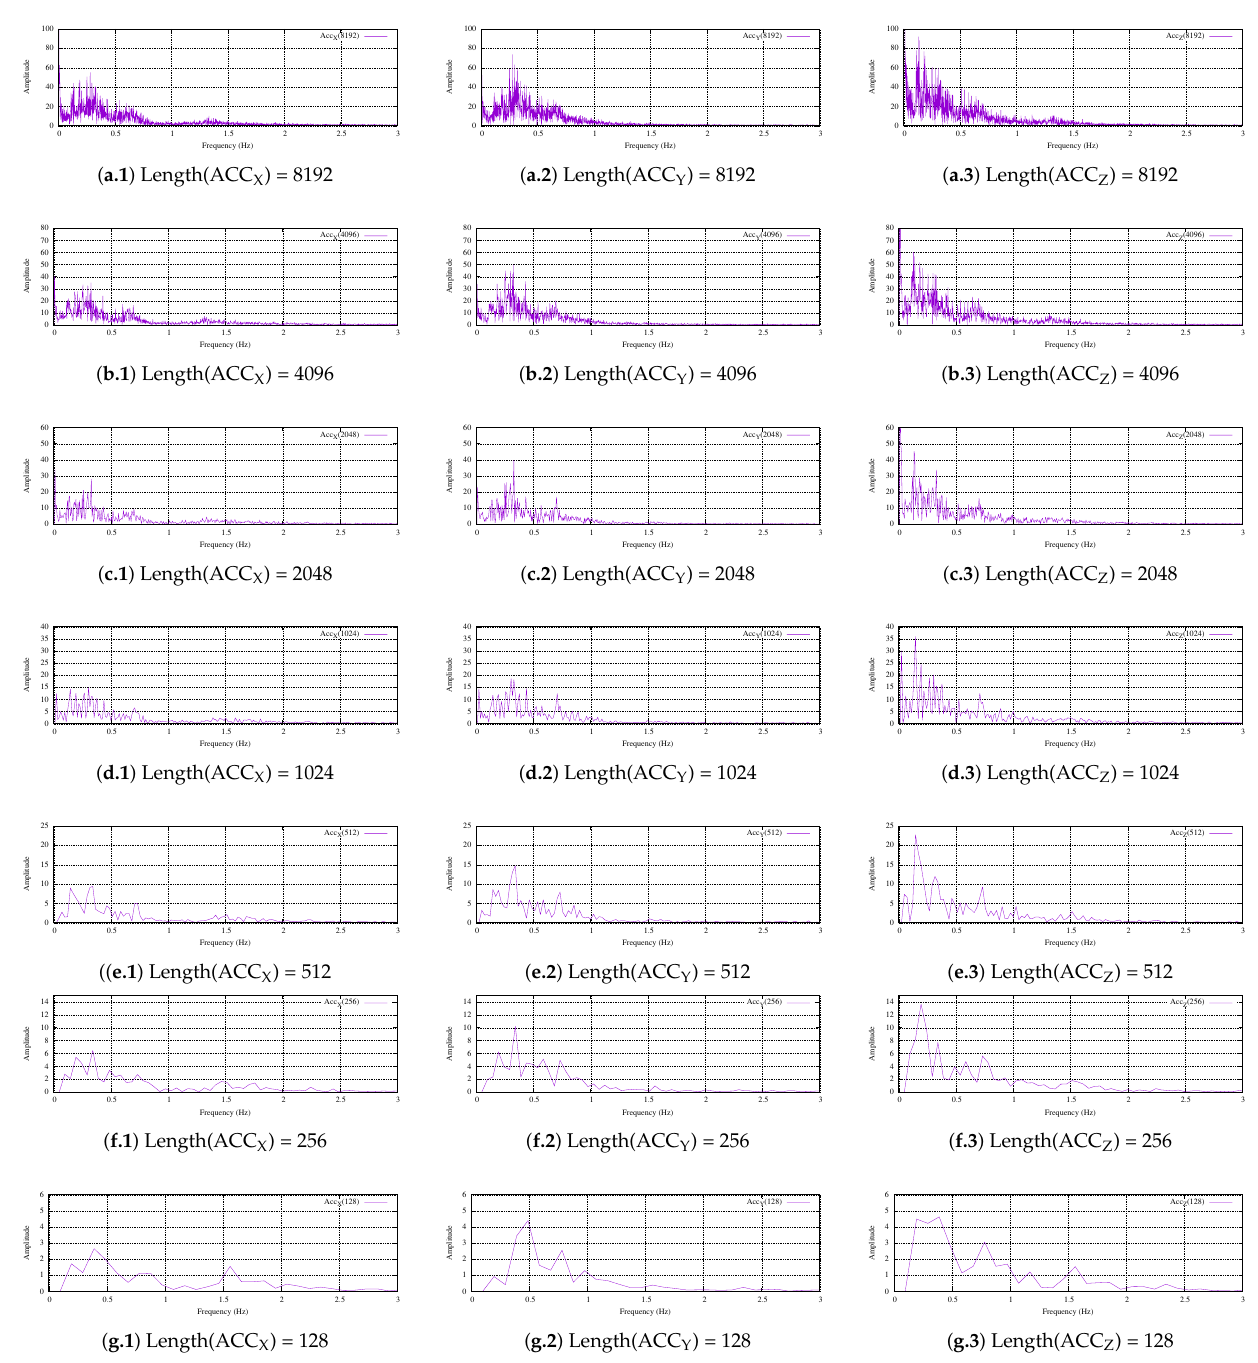
Figure 9. The frequency representations of the acquired data for the different acquisition